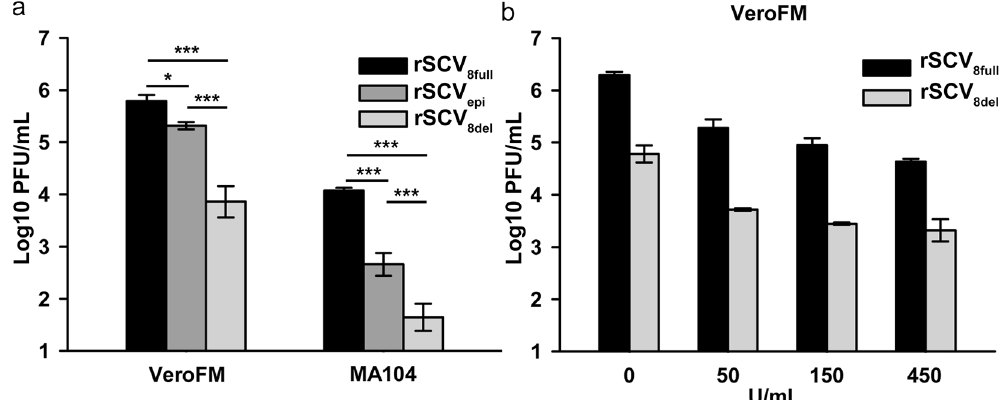
Figure 2. Replication of ORF8 variants in primate cell cultures with and without IFN pre-treatment. ( a ) VeroFM and MA104 cells were infected with three ORF8 variant viruses at MOI = 0.001. Supernatants were harvested at 24 hpi and virus titers determined by plaque titration. The experiment was done in triplicates. Significance of replication differences between virus variants was determined by t-Test ( *** p < 0.001, * p < 0.05). ( b ) VeroFM cells were incubated with universal type I IFN at indicated concentrations 16 h prior to infection with rSCV 8full and rSCV del8 at MOI = 0.001. At 24 hpi supernatants were plaque titered. Experiments were done at least twice in triplicates. Shown is one representative experiment each. Error bars represent standard deviation of the